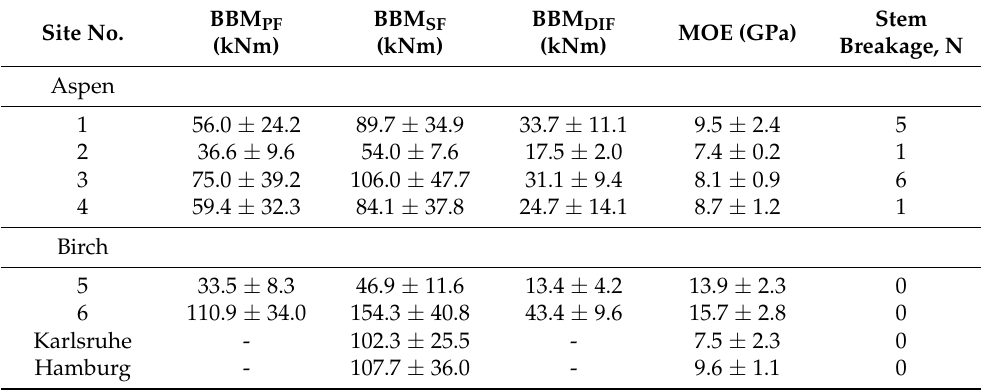
Table 2. Mean ( ± 95% confidence interval) basal bending moment of aspen and birch at primary (BBM PF ) and secondary failures (BBM SF ) and the difference between them (BBM DIF ), the modulus of elasticity (MOE), and the number of trees with stem failure in each sampled site. BBM PF Site No. (kNm)